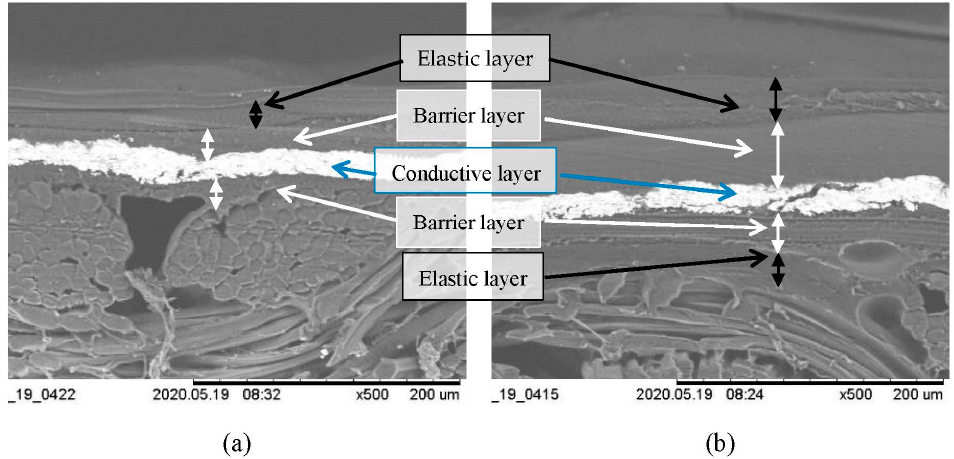
Figure 10. SEM images of samples single-layer coated ( a ) and double-layer coated ( b ).